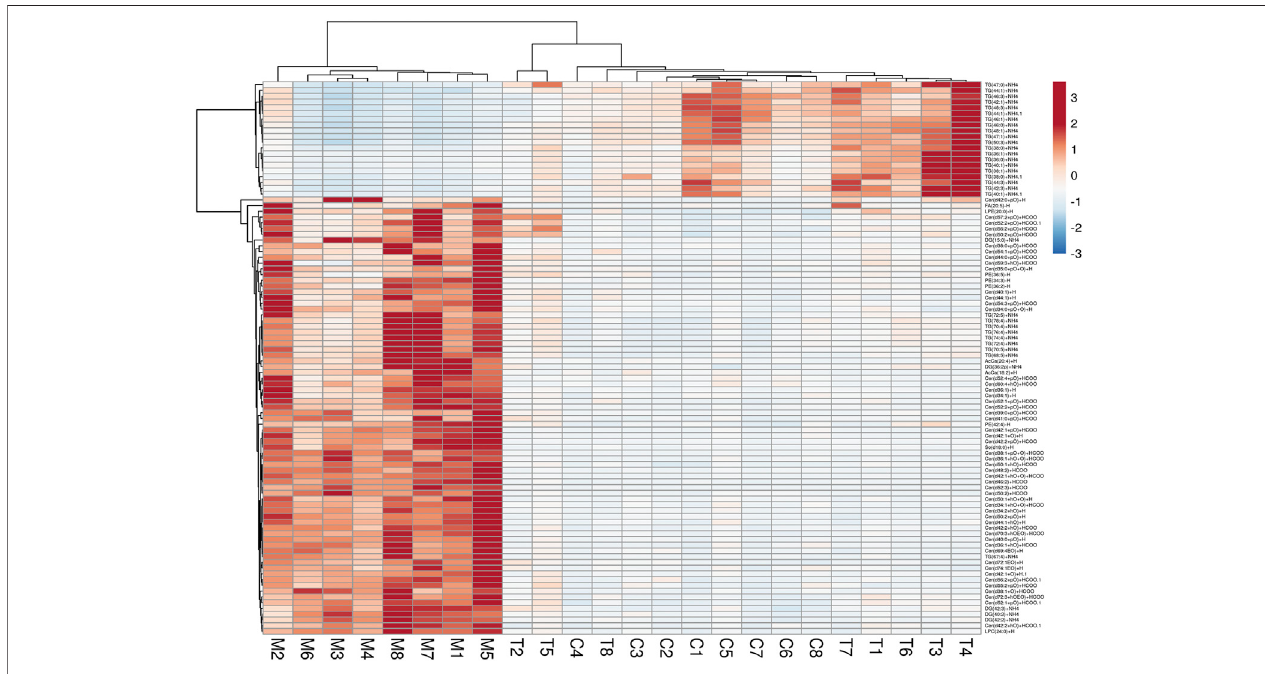
FIGURE 7| Heatmap of 96 lipid species among the experimental groups. Each lineof this graph representsan accurate mass ordered by the retention time and is colored by its abundance intensity. The scale from − 3 blue (low) to + 3 red (high) represents the abundance.